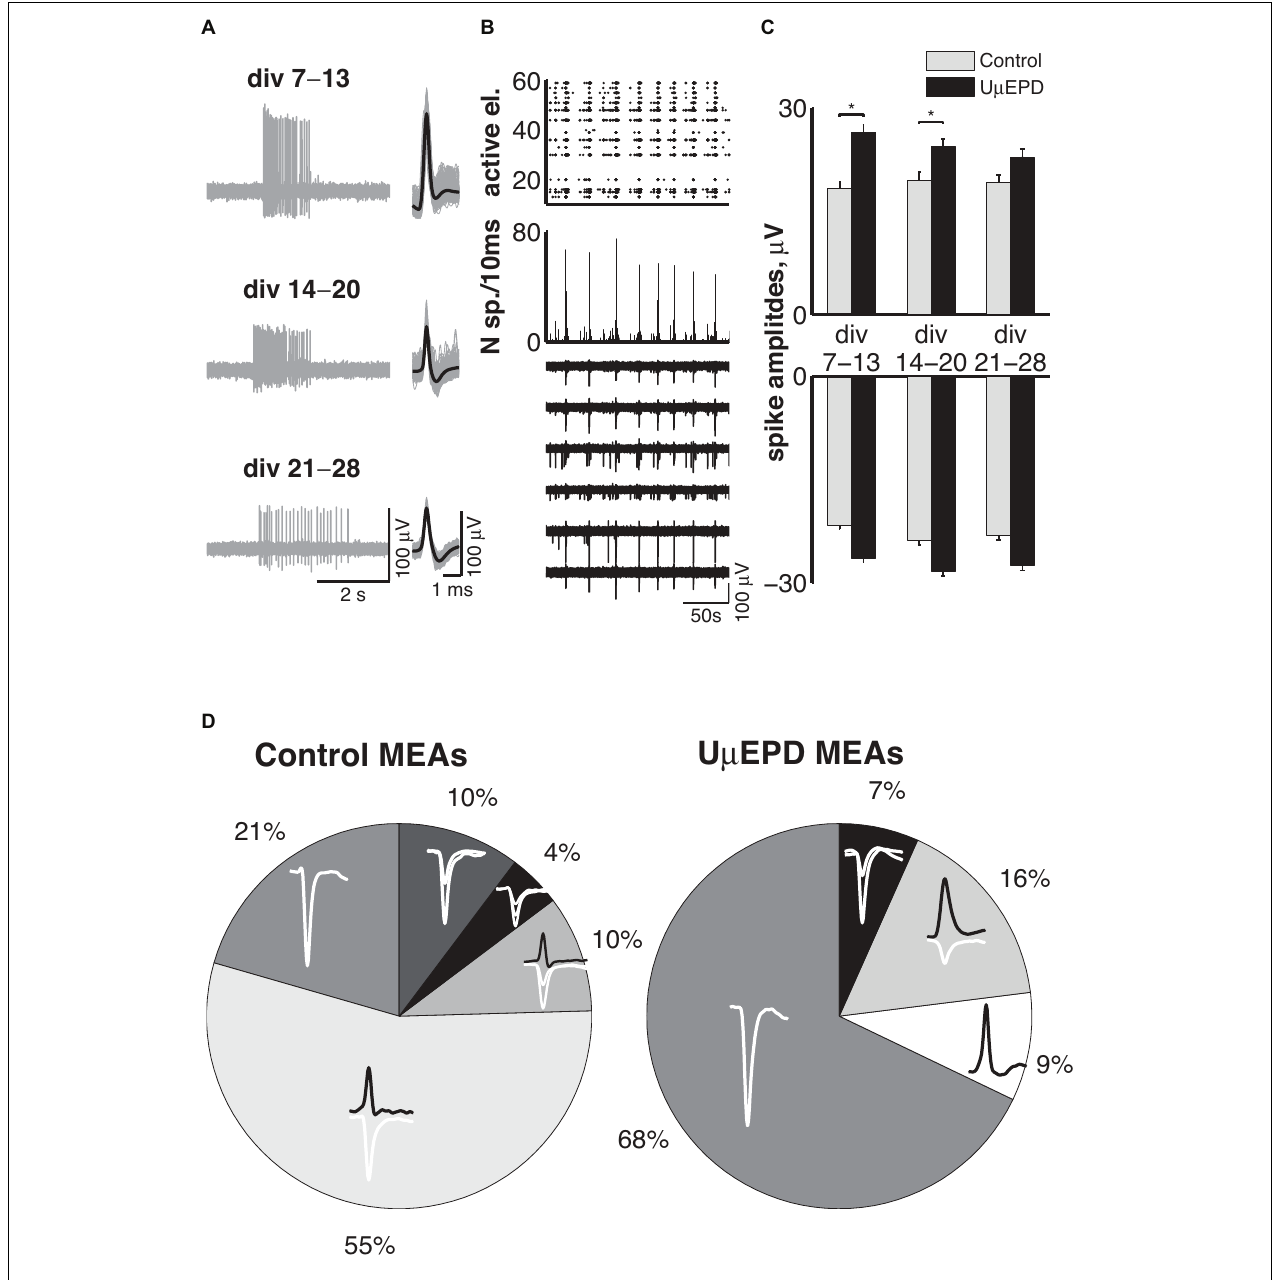
FIGURE 5 | Biocompatibility, stability of ultramicroelectrodes, and spike-waveforms classification. Representative example of recordings from DIV7 up to DIV28 of spontaneous neuronal activity with PEDOT:PSS ultramicroelectrodes ( A , left) and extracted spike waveforms ( A , right); periodic synchronized network behavior within 200 s is presented by spike-time (black dots) raster plot over all PEDOT:PSS ultramicroelectrodes ( B , top), histogram of spike time computed for 10 ms intervals across all microelectrodes ( B , middle) and extracellular recording with six PEDOT:PSS ultramicroelectrodes ( B , bottom) during corresponding time; the distribution of the average amplitudes with positive ( C , top) and negative ( C , bottom) deflections over 3 weeks of neuronal network development detected with control (gray bars, n = 12 MEAs) and PEDOT:PSS ultramicroelectrodes (black bars, n = 10 MEAs) microelectrodes, data are shown as mean ± SEM; classification of spike waveforms detected by planar microelectrodes ( D , left, n = 4 MEAs) revealed that the majority (79%) of planar electrodes detects signal with several different spike shapes simultaneously, whereas the majority of PEDOT:PSS ultramicroelectrodes (77%) microelectrodes registered only single waveform of spikes ( D , right, n = 7